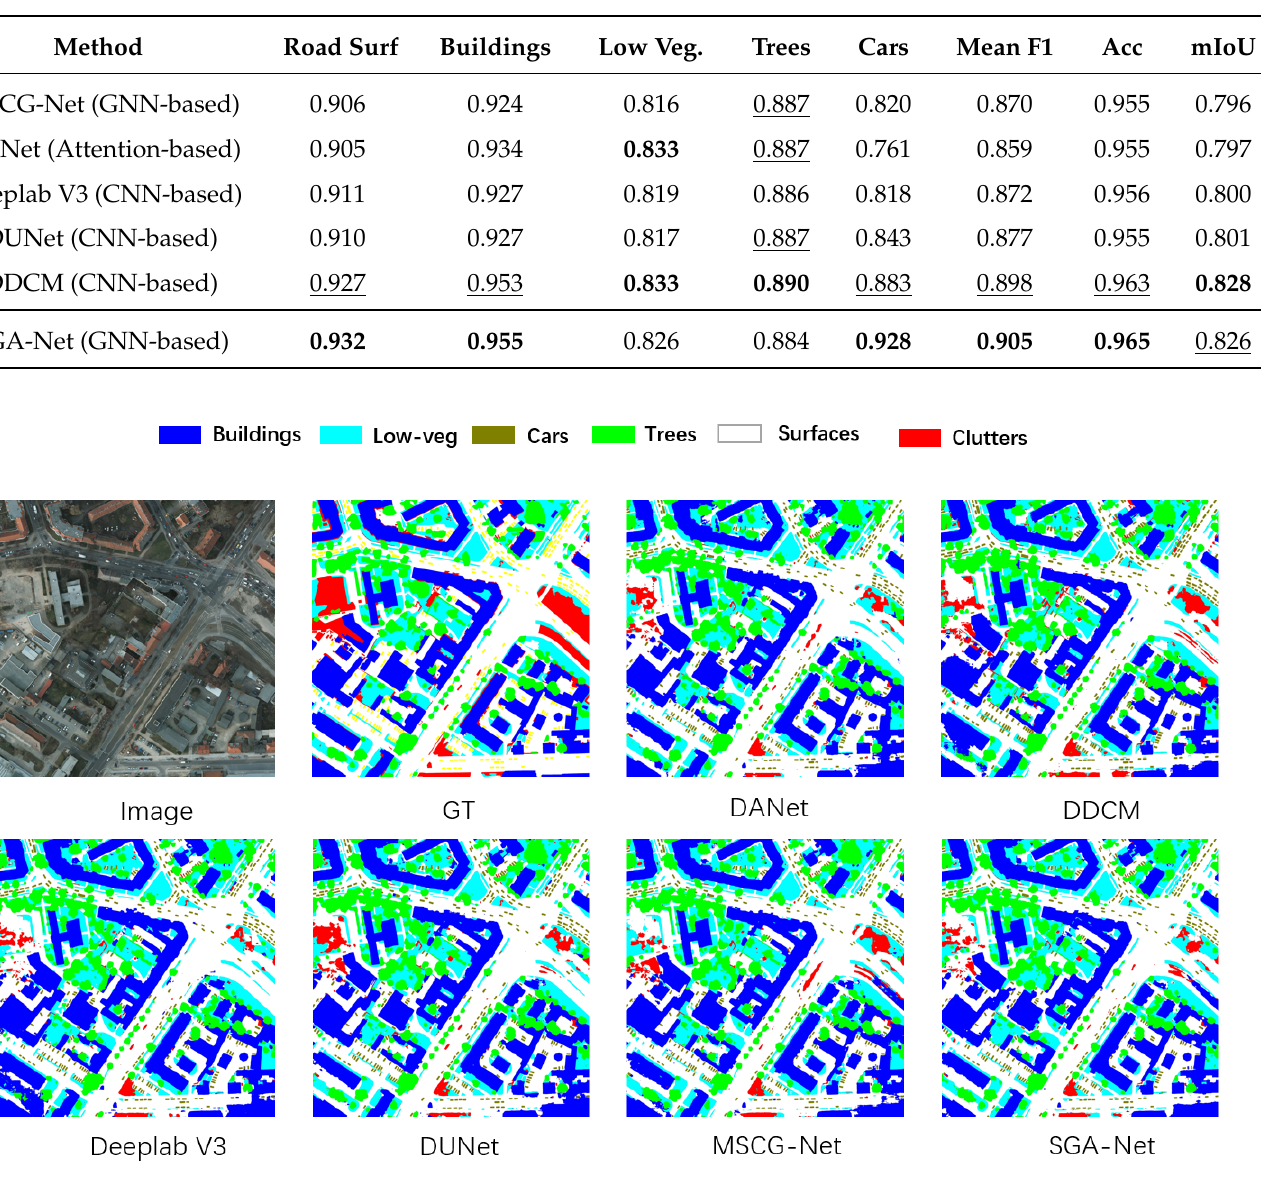
Figure 3. Visualization of tile5_15 in the Potsdam